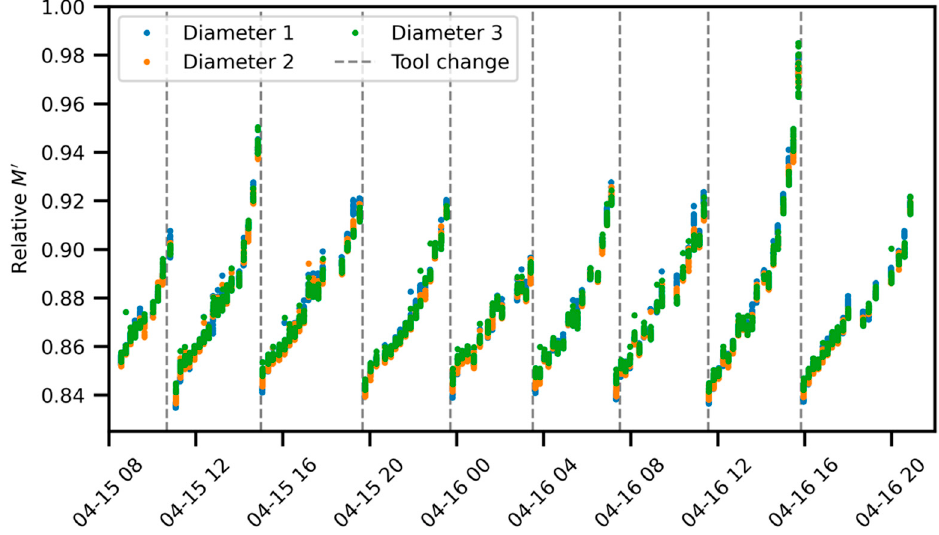
Figure 6. The computed normalized spindle torque M’ increases towards the end of each tool’s lifetime. The axis shows the wall clock time (month, day, and hour).